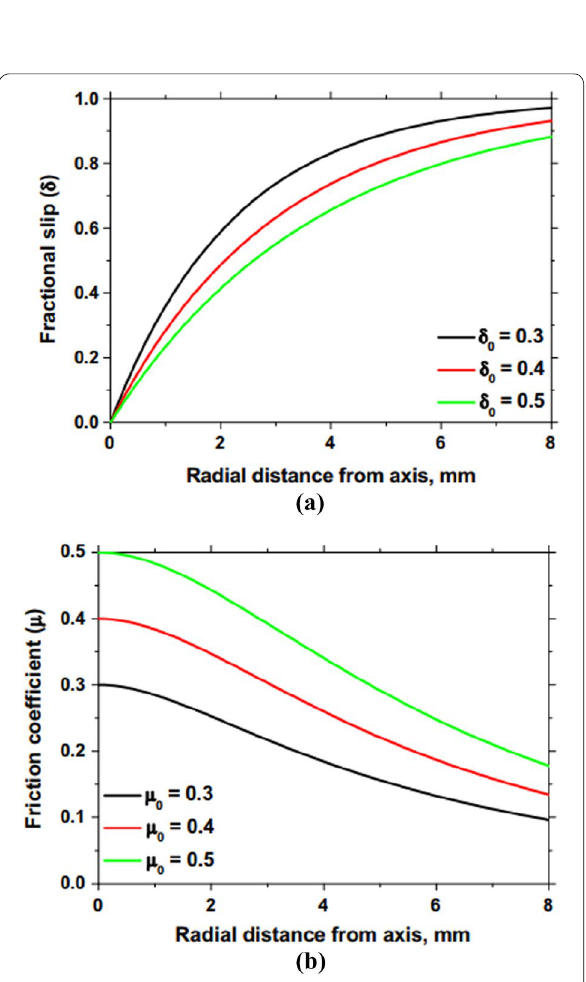
Figure 34 The relationship between ( a ) the frictional slip and ( b ) the friction coefficient with the radial distance